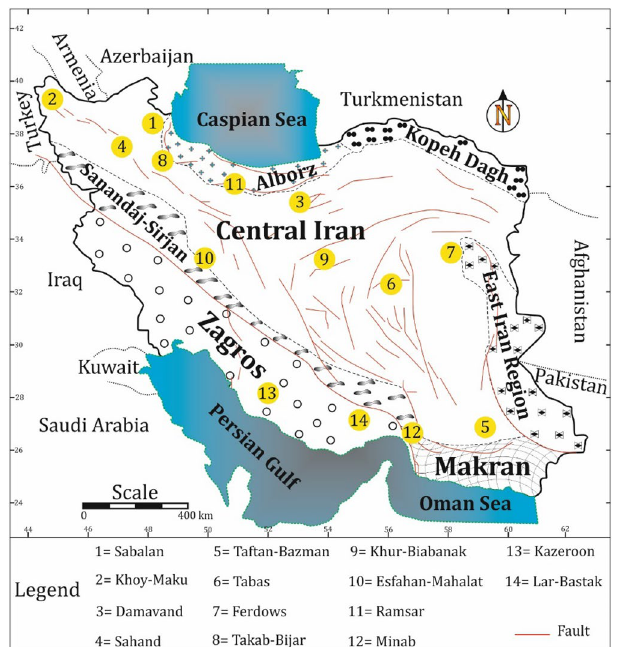
Figure 1. Geologic zonation of Iran and geothermal prospects existing within this plateau (adopted from 22,40 and generated by corelDRAW version 22.1.1.523). Numbers represent the location and each location with its related number is explained in the legend. Numbers also show the importance of locations decreasing from 1 to